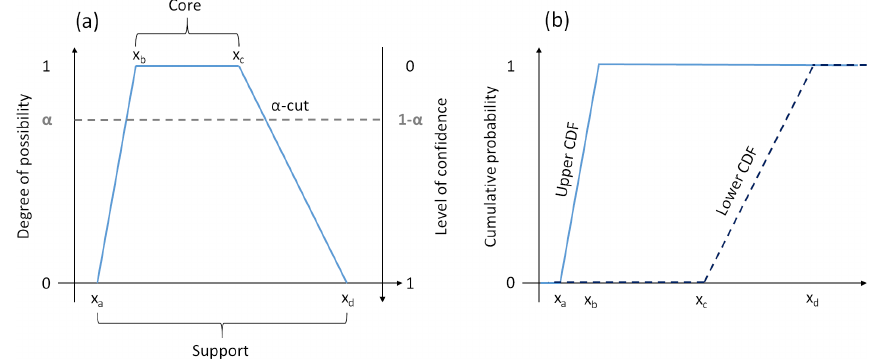
Figure 1. Example of (a) trapezoidal possibility distribution and (b) its translation into a probability box.